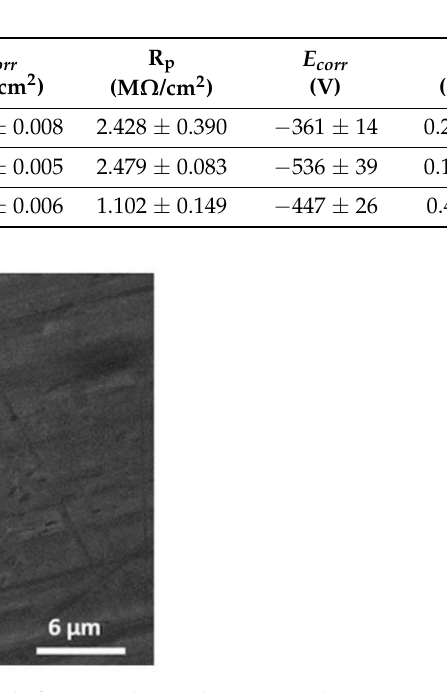
Figure 7. Pitting corrosion marks produced after completing the potentiodynamic test on a Grade 5 titanium alloy surface passivated with Piranha solution.